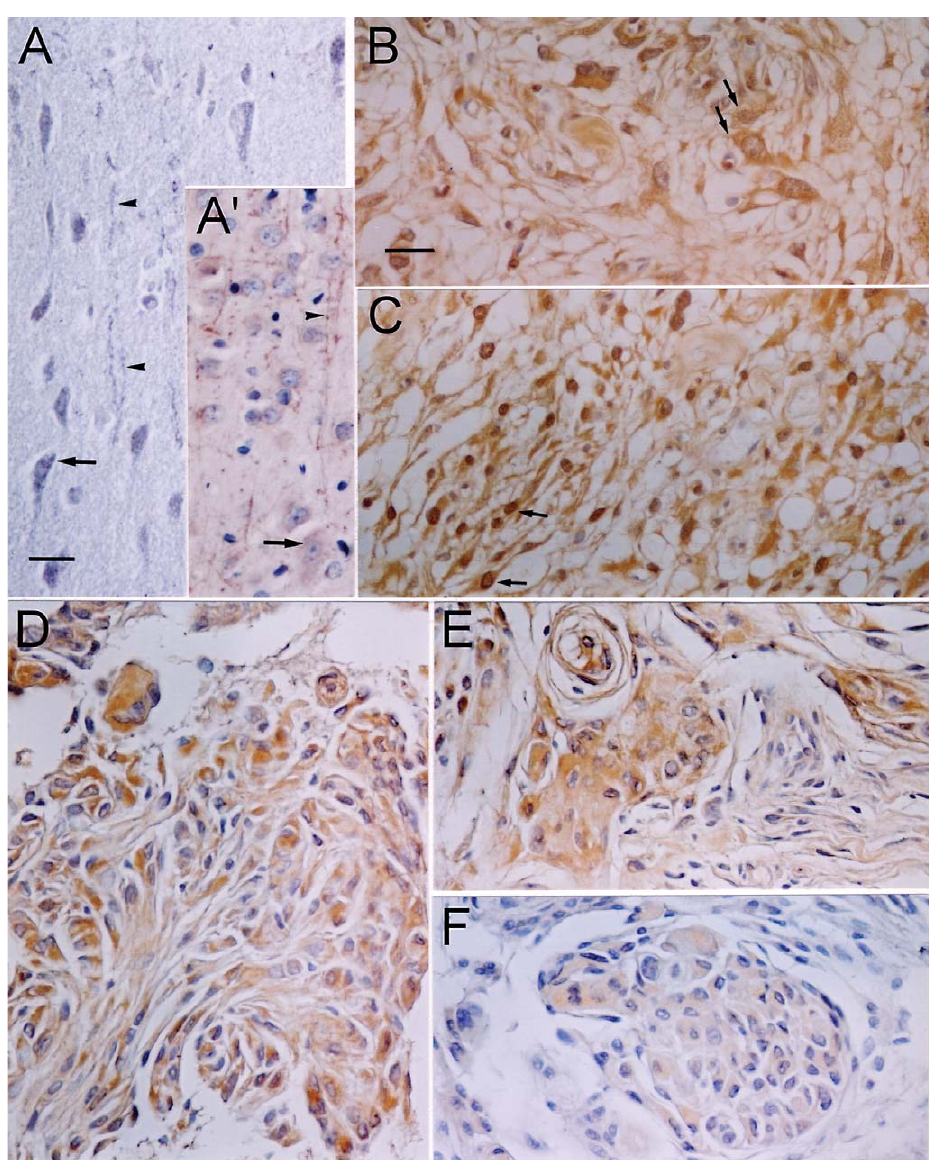
Fig.1. WOX1immunoreactioninnormalcontrol(a)andbraintumors(b-e).Innormalhuman(a)andmurine(a’)brains,WOX1wasmoderately presentonthenervefibers,suchastheaxonsofpyramidalcells(arrowheads),whereasthestainingintensitywaslowincorticalneurons(arrows). High levels of WOX1 were detected in microcystic (b, c) and malignant (d, e) meningiomas. In the microcystic meningiomas (b, c), WOX1 expression appeared in the cytosol of polygonal small to large cells with oval or round nuclei (arrows). Perivascular hyalinization was negative for WOX1, but endothelial cells and smooth muscles were immunoreactive in some large blood vessels (data not shown). In the malignant cases (d, e), many small whorls were scattered in the tumor. Moderate to high staining intensity was observed in the small whorls in storiform arrangement, whereas low levels of WOX1 appeared in the spindle cells with elongated nuclei around the outer portion. A similar pattern for NF2/merlin expression in the cluster of malignant meningiomas was also observed (F). Bar=50 (cid:1) m. erate to high staining intensity was observed in the elongated nuclei around the outer portion. Figure 1F small whorls with storiform arrangement, whereas low shows NF2/merlin expression in a cluster of malignant levels of WOX1 appeared in the spindle cells with meningioma, resembling that of